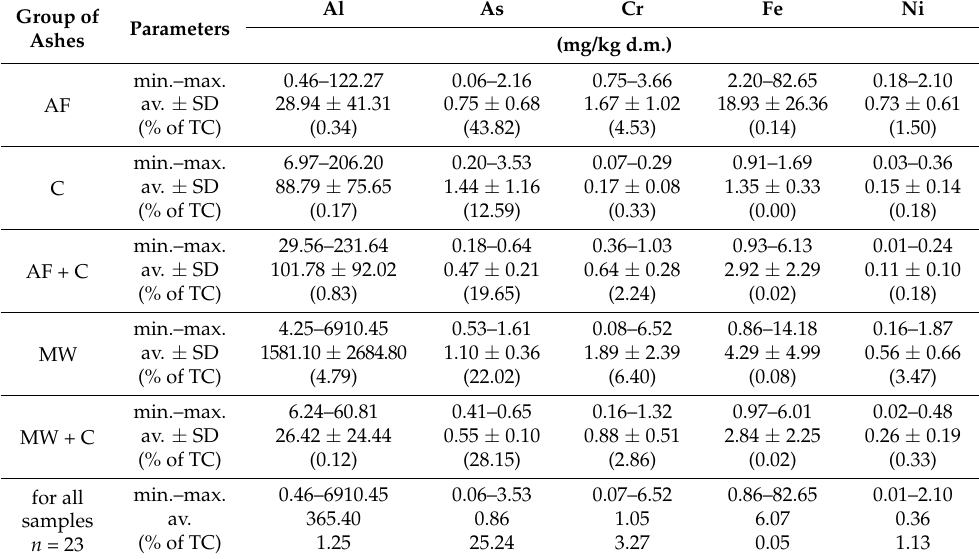
Table 4. Bioavailable fraction of PTEs in household